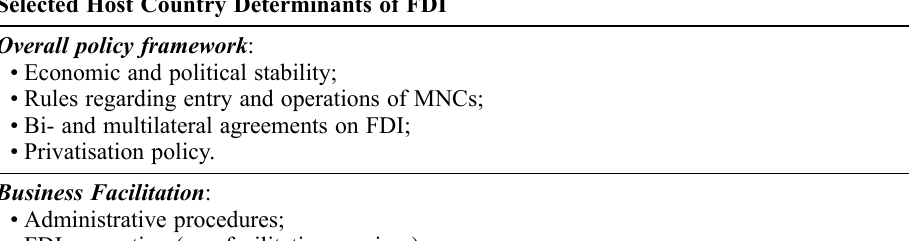
Table 1. Selected Host Country Determinants of FDI ( Source: Nunnemkamp 2003) Selected Host Country Determinants of FDI Overall policy framework